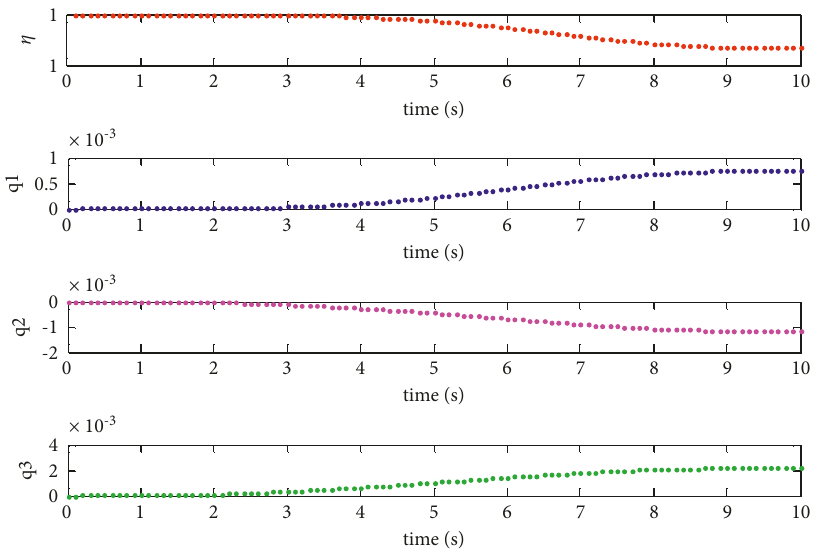
Figure 12: The attitude of the base obtained by the SAPSO algorithm. Table 5: The comparison of the computing time. Algorithms QPSO PSO SAPSO IQPSO